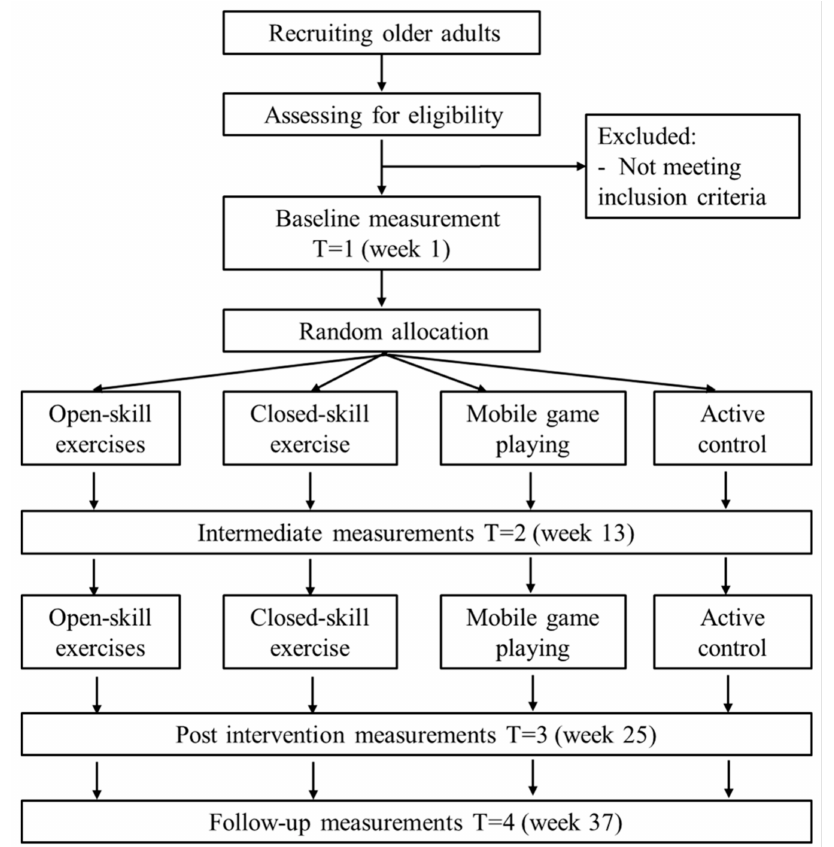
Figure 1. Flowchart of the study